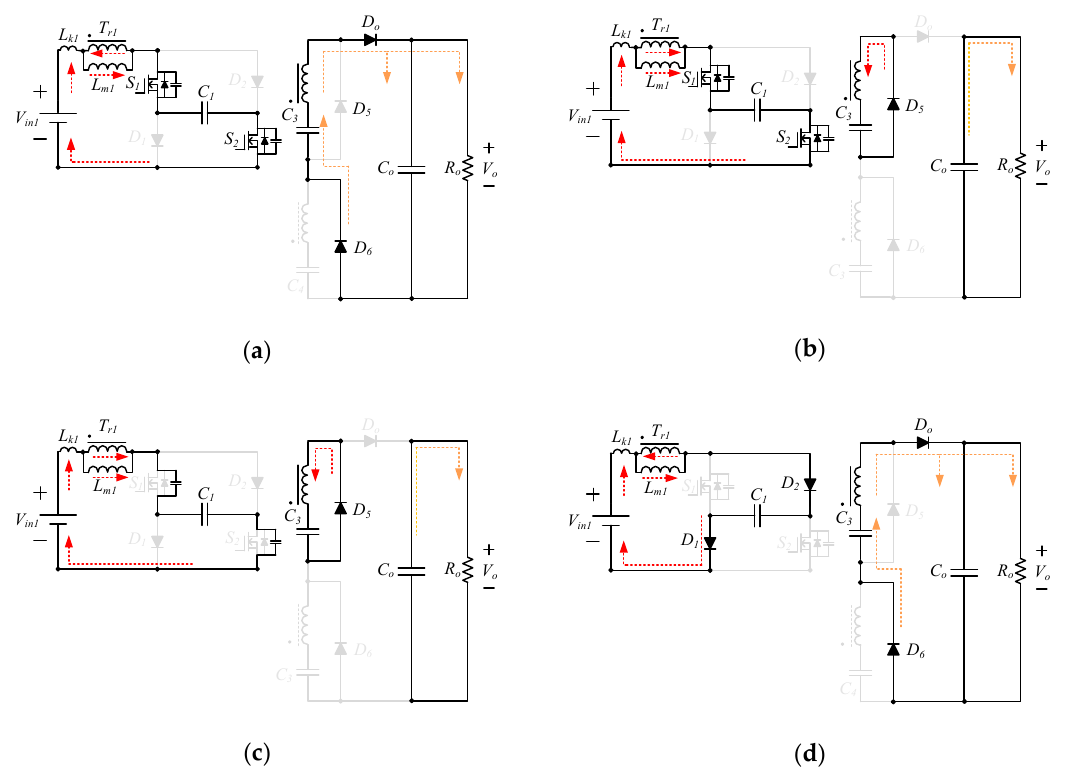
Figure 6. The equivalents of the proposed converter at SIO and CCM operation: ( a ) State 1, ( b ) State 2, ( c ) State 3, ( d ) State